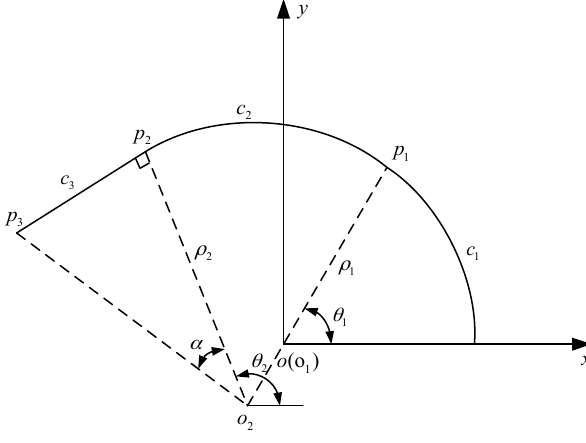
Figure 7. Schematic diagram of plane curve fitting.